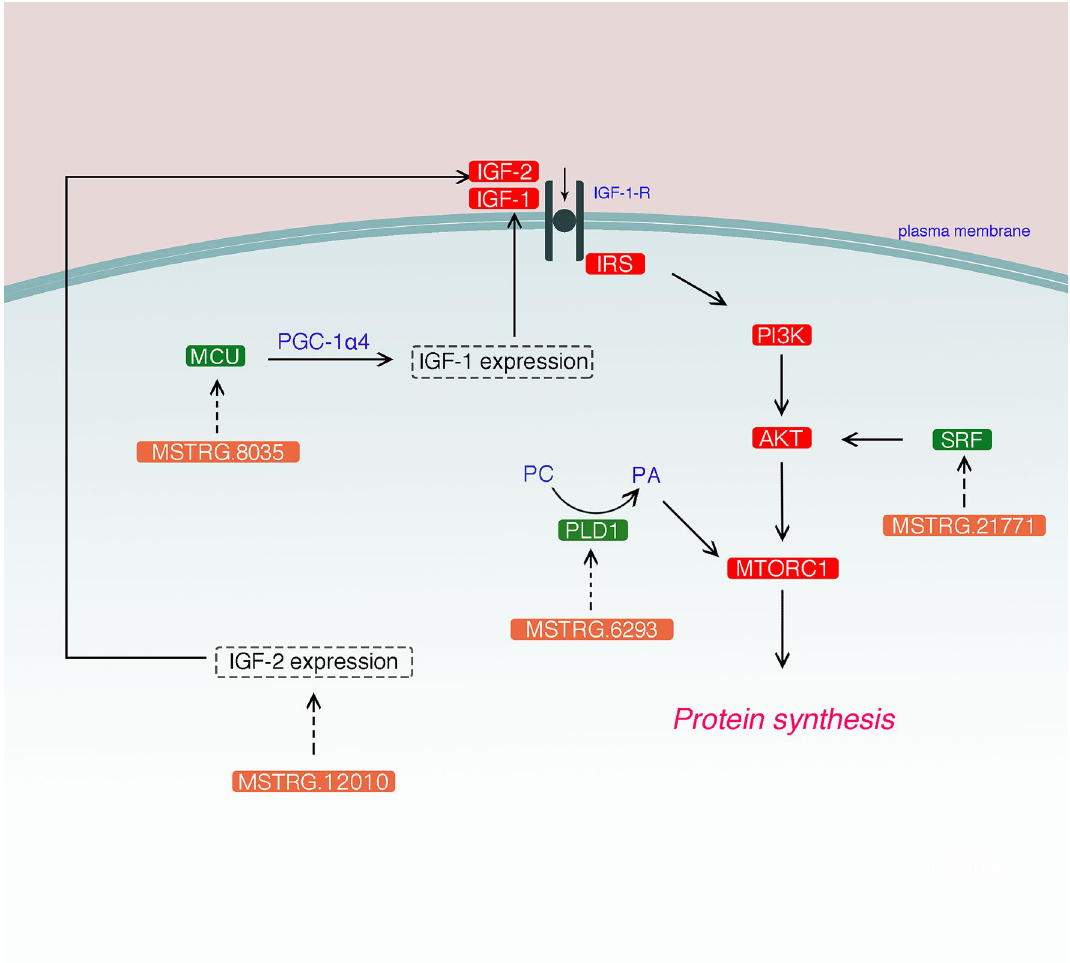
Figure 8. Schematic diagram of lincRNAs involvement in muscle fiber hypertrophy signaling by regulating its target genes. IGF-1, insulin-like growth factor-1; IRS, insulin receptor substrate; PI3K, phosphatidylinositol 3 kinase; mTORC1, mechanistic target of rapamycin in complex 1; IGF-2, Insulin-like growth factor 2; TNNT3, troponin T-3; SRF, Serum response factor; PLD, phospholipase D; PC, phosphatidylcholine; PA, phosphatidic acid; MCU, Mitochondrial calcium unidirectional transporter. Red indicates key genes in the IGF-1-Akt-mTOR signaling pathway; orange indicates lincRNA; and green indicates